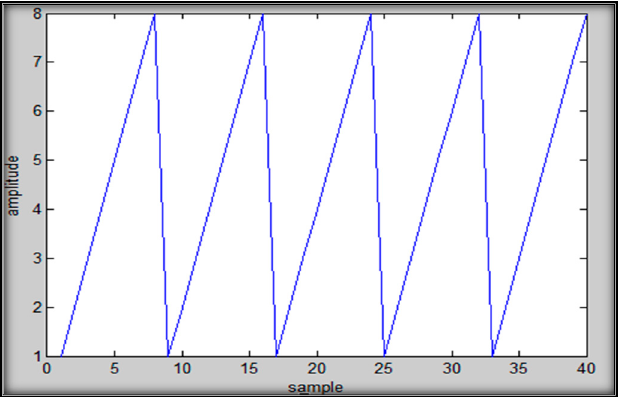
Figure 10. Normal communication (Tx to Rx).